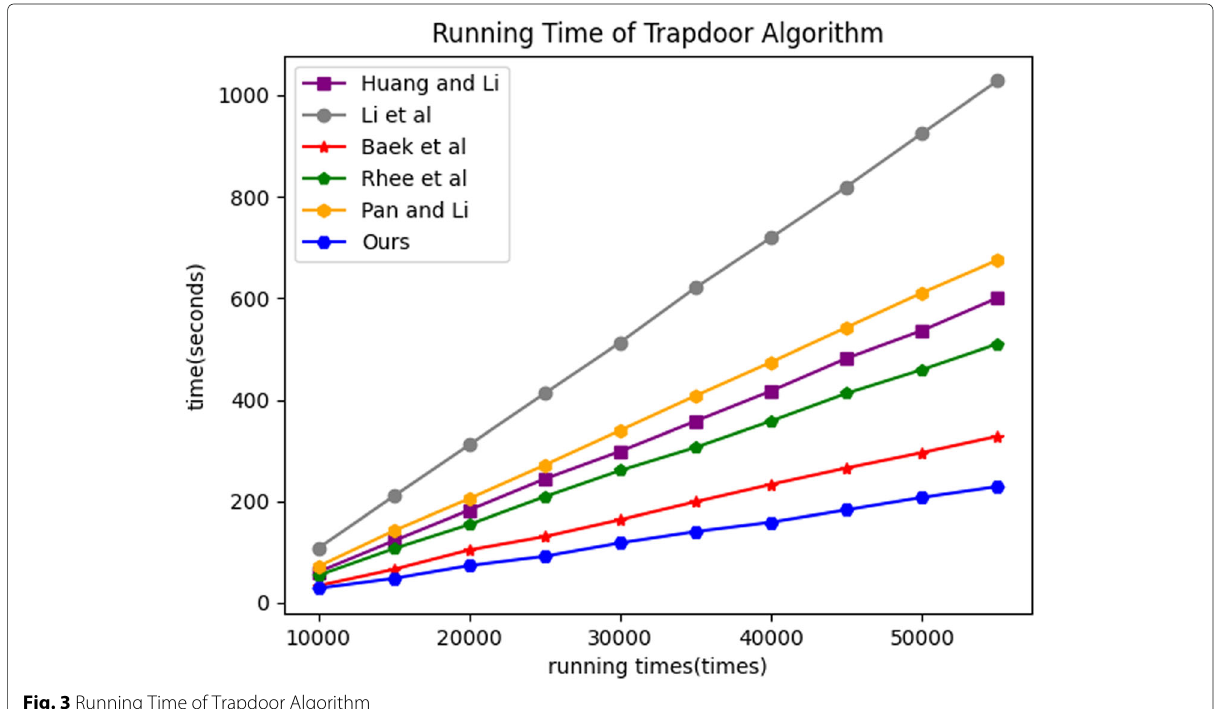
Fig. 3 Running Time of Trapdoor Algorithm